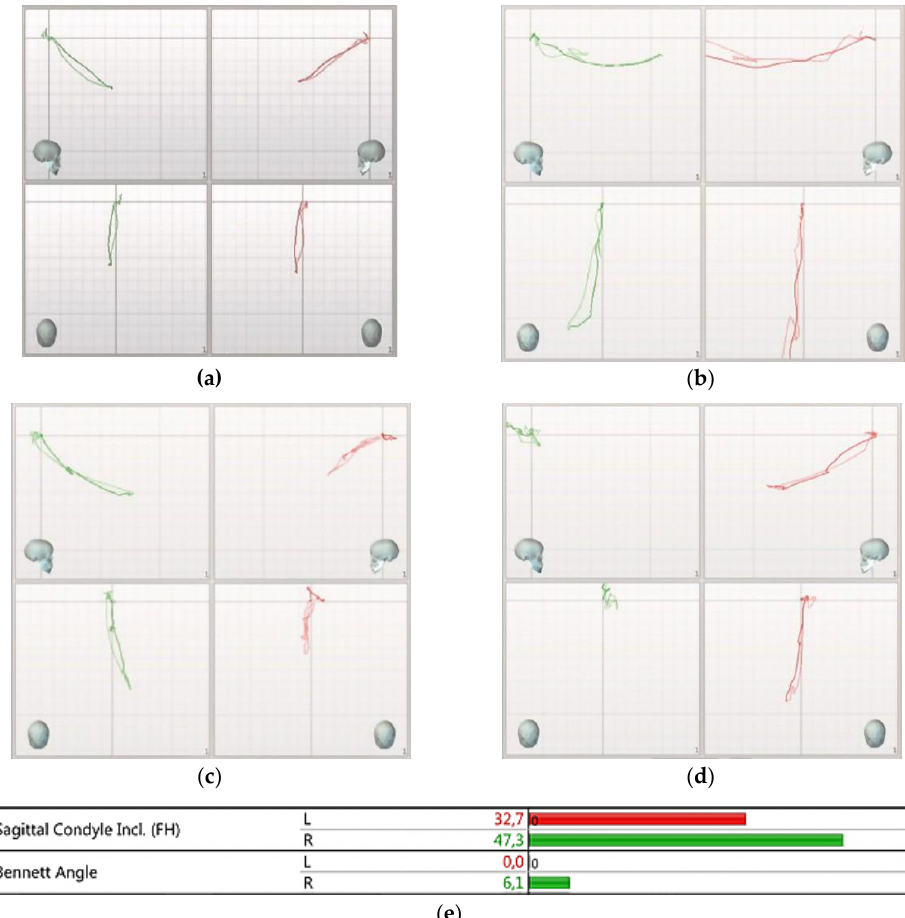
Figure 3. Initial condylographic recordings: ( a ) protrusion/retrusion tracing; ( b ) open/close of the mouth tracing; ( c ) mediotrusion right tracing; ( d ) mediotrusion left tracing; ( e ) SCI and TCI values of the right (green) and left (red) condyles.